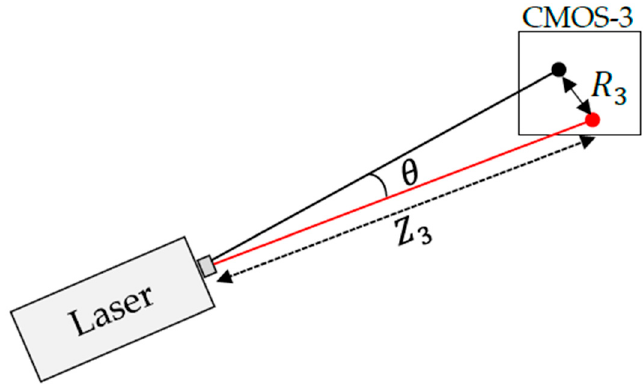
Figure 4. Scheme to compute the angle of centroids. Source: Authors. Table 1. Summary of the main setup parameters.